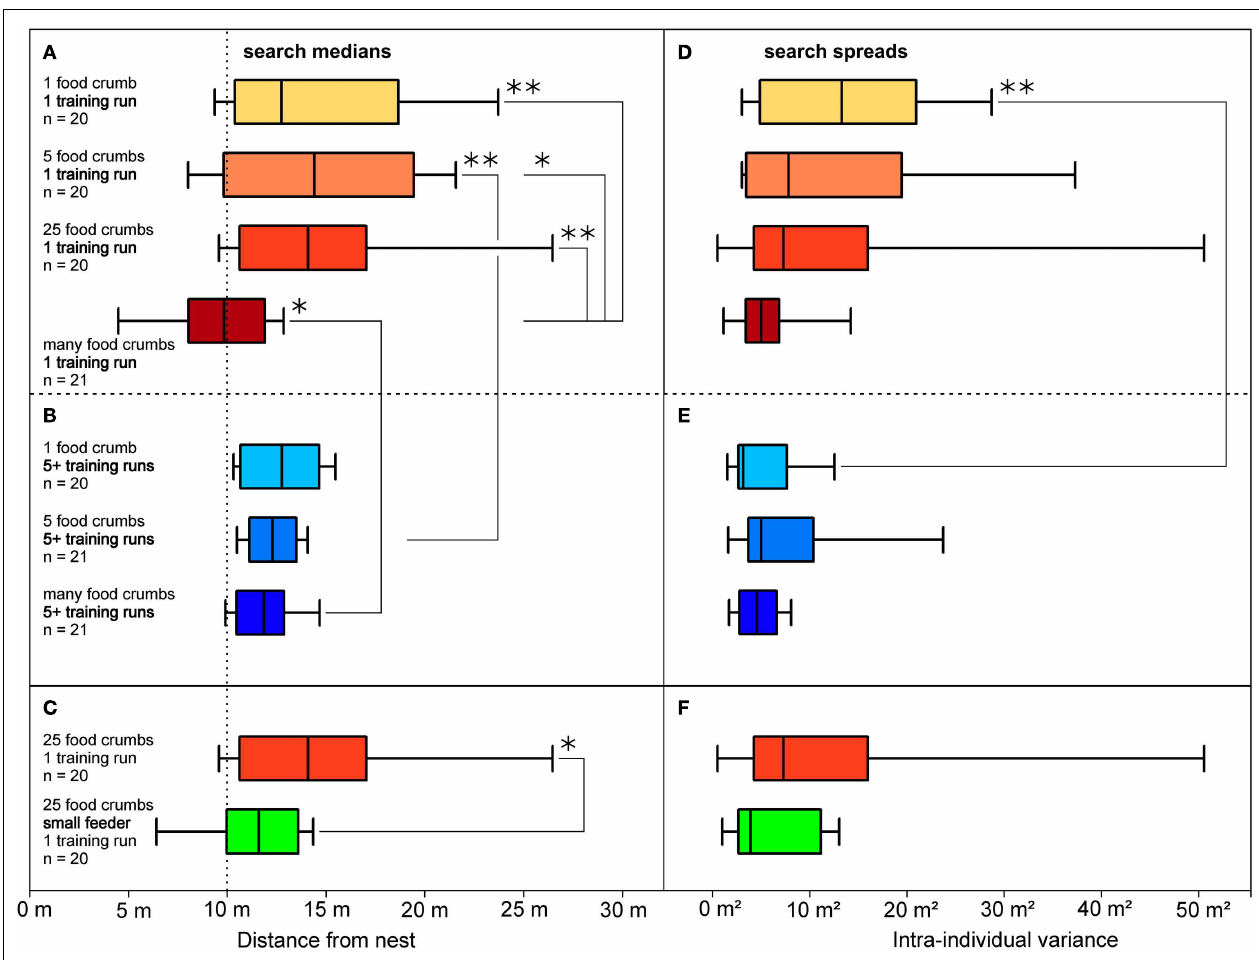
absence of significant difference is not indicated. (B,E) Data from ants that had performed five or more (training) visits; the experimental groups differed in the amount of food available in the feeder; other labels as in (A) . (C,F) Data from ants that had visited a feeder equipped with 25 food items once before being tested.The feeder was either of standard size (32mm diameter; same situation as in (A) , bright red box) or small (8mm, green box); food density was thus 16-fold higher in the small feeder. Other labels as in (A) . Search medians are plotted on the left (A–C) , search spreads on the right (D–F) as variances of the individuals’